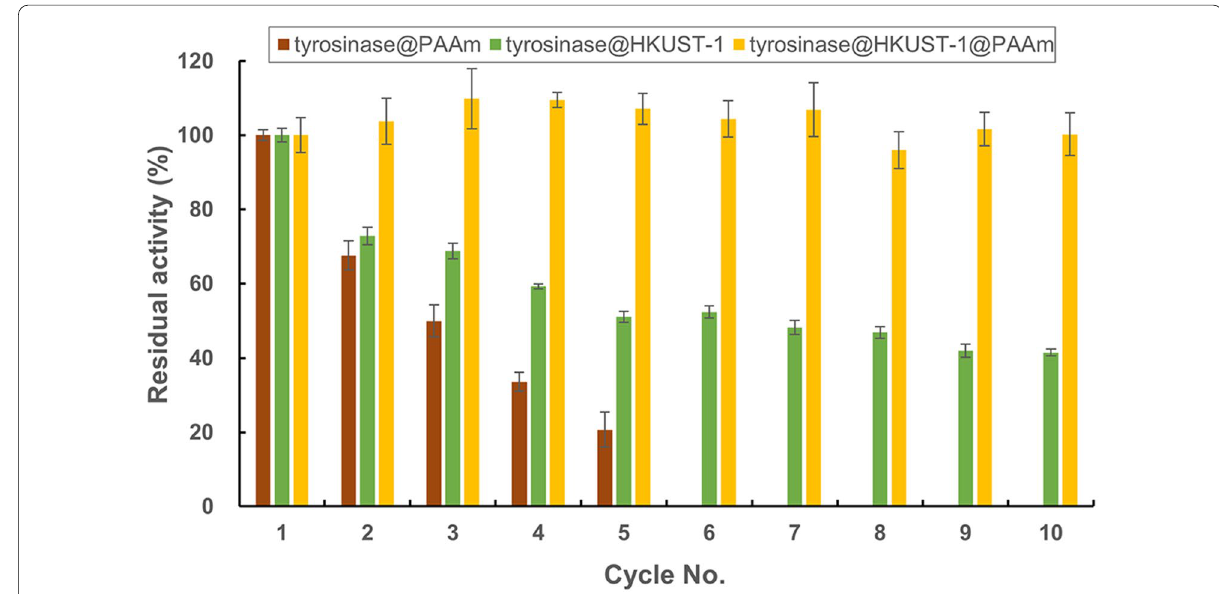
Fig. 4 Recyclability of